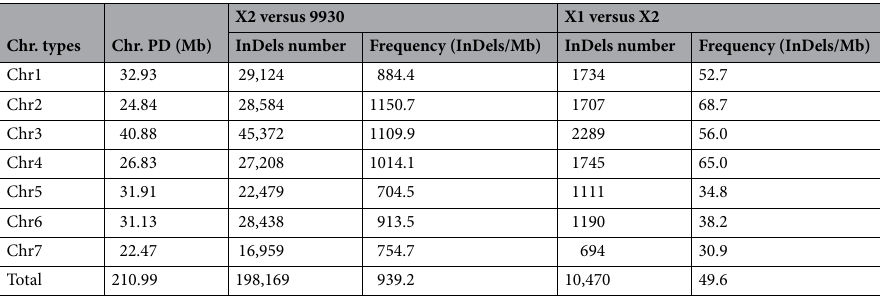
Chr. types Chr. PD